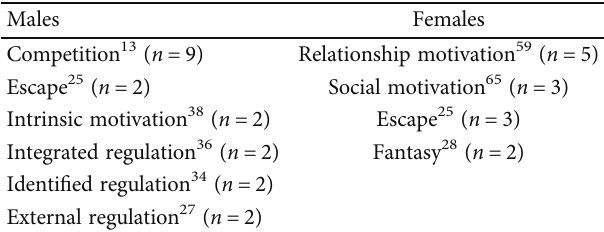
Table 4: Most agreed motivation for gender and number of papers that support these fi